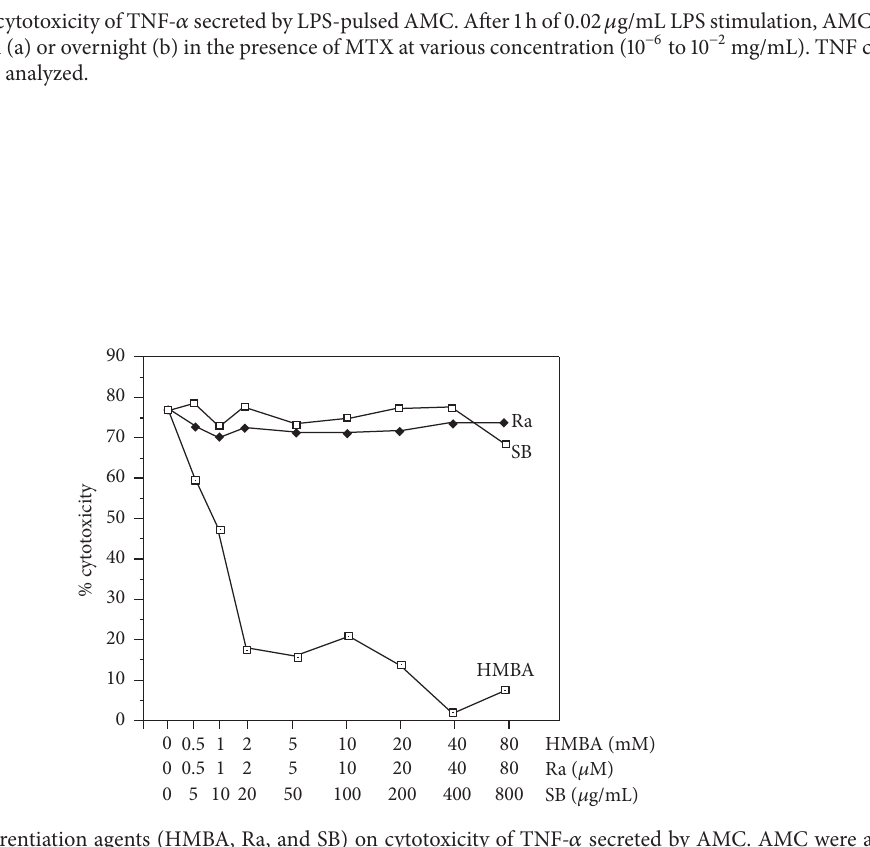
Figure 7: Effect of cytodifferentiation agents (HMBA, Ra, and SB) on cytotoxicity of TNF- 𝛼 secreted by AMC. AMC were activated with 0.02 𝜇 g/mL LPS in the presence of cytodifferentiation agents at various concentrations (as summarized in Table 1). After overnight culture, cell-free supernatants were harvested and TNF cytotoxicity in 10x diluted supernatants was